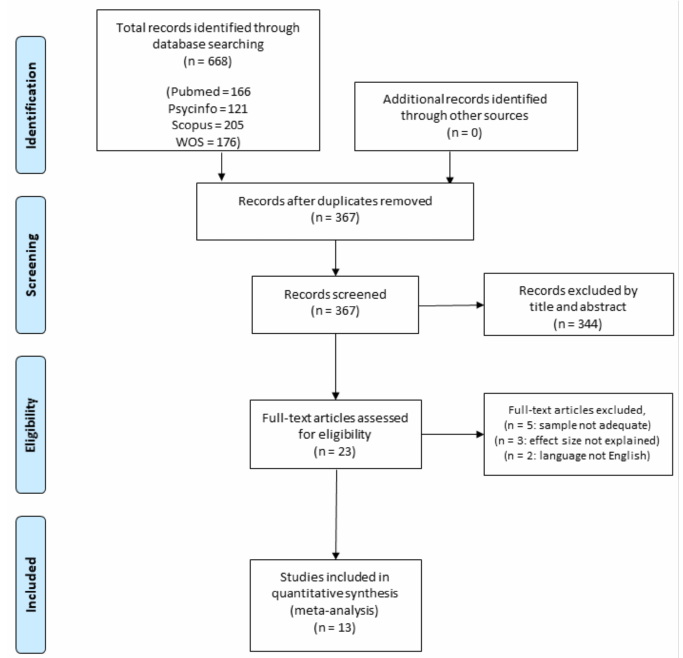
Figure 1. Flow diagram for screening and selection of